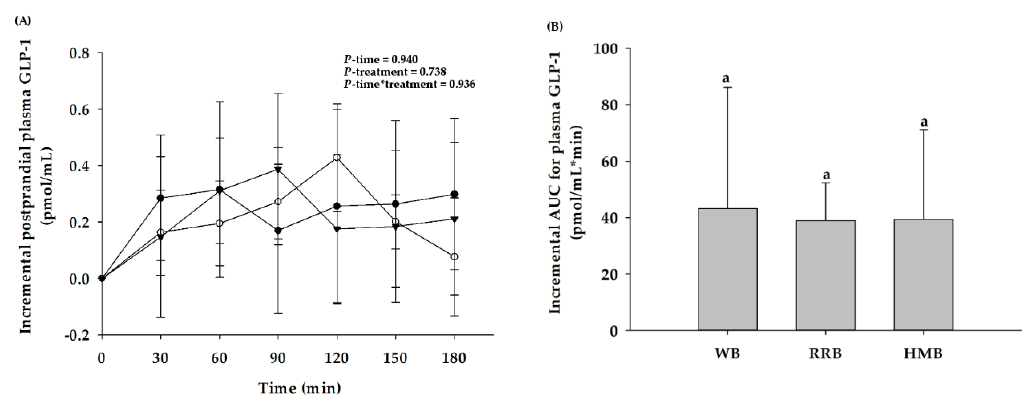
Figure 6. ( A ) Postprandial plasma GLP-1 changes and ( B ) the iAUCs for plasma GLP-1 in healthy participants after the consumption of wheat bread (WB), Riceberry rice bread (RRB), and Hom Mali bread (HMB). All values are means ± SEM, n = 16. WB (●), RRB ( ○ ), and HMB ( ▼ ). For each time point, means with a different letter are significantly different, p < 0.05.